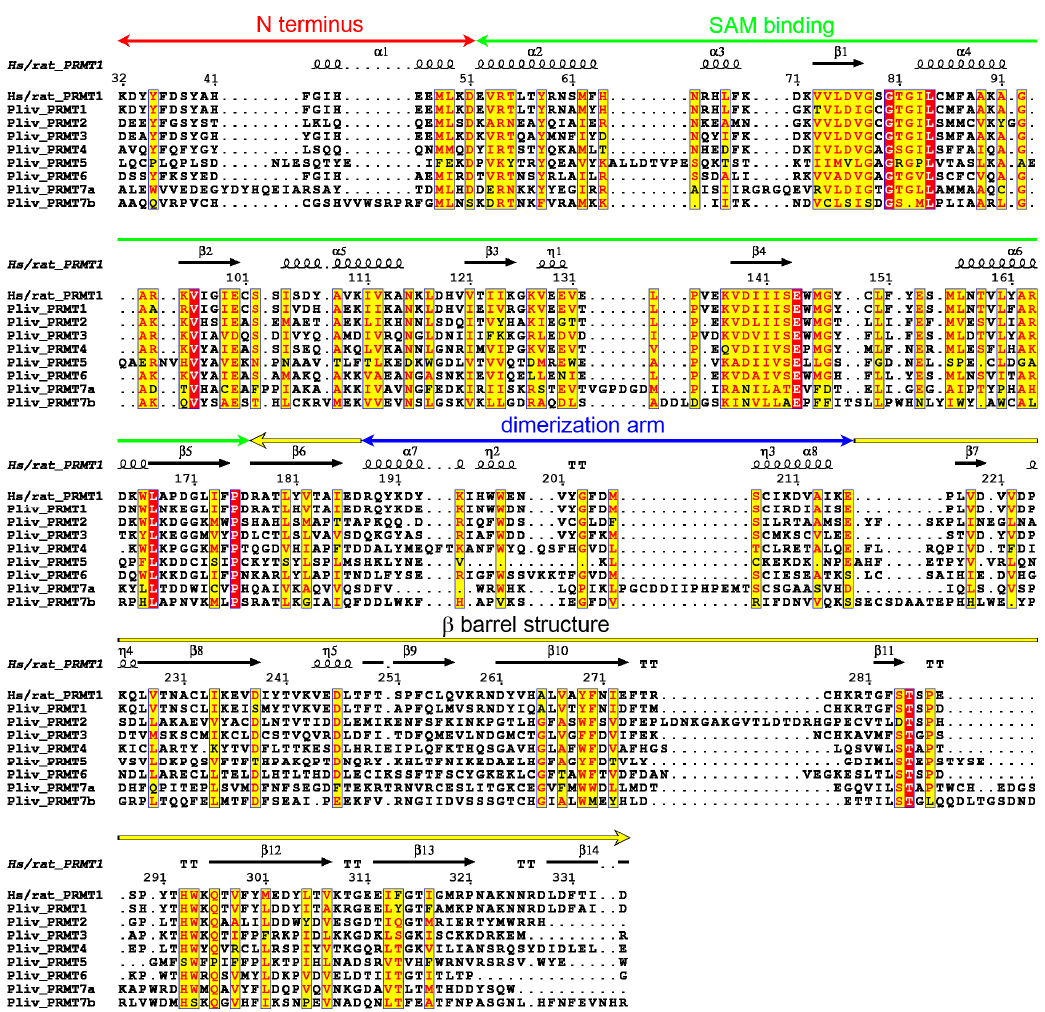
Figure 7. MSA of the methyltransferase domains (ProSite ID PS51678) of human and rat PRMT1 and P. lividus PRMT family performed with T-Coffee. Similar residues are written in black bold characters and boxed in yellow whereas conserved residues are in white bold characters and boxed in red. The sequence numbering on the top refers to the rat PRMT1 sequence (Q63009). PRMT1 domains and secondary structures are highlighted on the top; the colour coding is red for the N terminus (residues 41–51), green for the SAM binding domain (residues 52–176), yellow for the β barrel structure (residues 177–187 and 217–352), and blue for the dimerization arm (residues 188–216), as depicted in Zhang and Cheng [85].